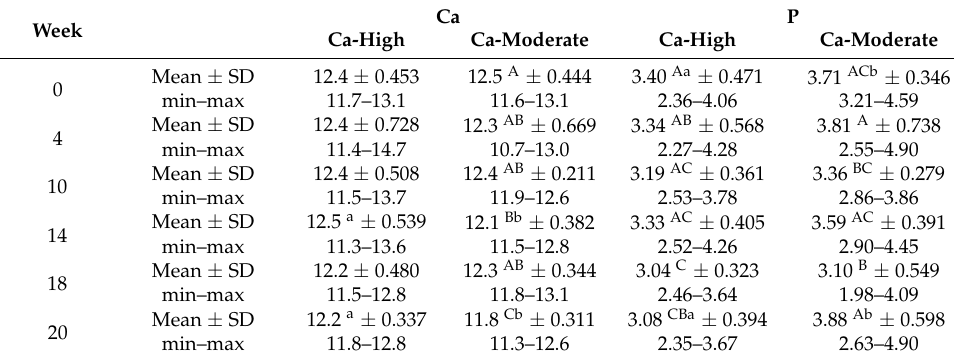
Table 5. Calcium and phosphorus serum concentrations of the stallions (mean ± SD; min–max), given in mg/dL.